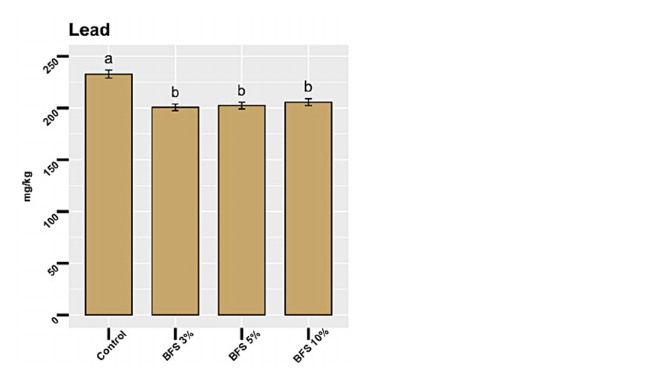
Figure 5. PTE content in soil with the addition of Blast Furnace Slag (BFS).